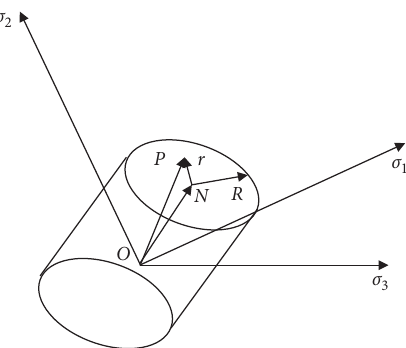
Figure 3: Mises yield criterion in the principle stress